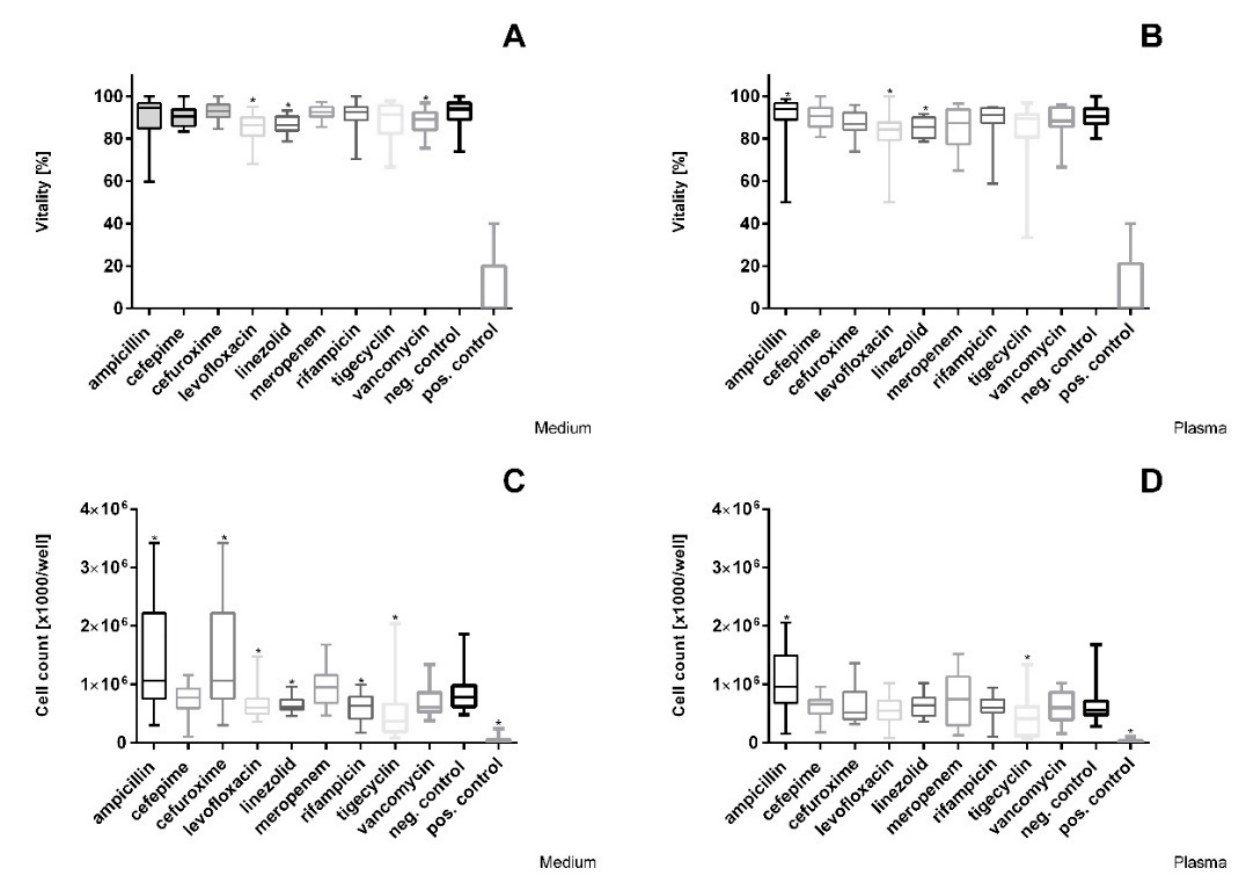
Figure 1. Representation of the Cmax concentration. Vitality (trypan blue staining) of HepG2/C3A cells after exposure to ( A ) antibiotics in medium and ( B ) antibiotics in plasma, as well as cell count of hepatocytes after exposure to ( C ) antibiotics in medium and ( D ) antibiotics in plasma at Cmax. Values represent median and 25th/75th percentile of three replicate wells from four different experiments. Significance between control and exposure groups is indicated by * p < 0.05.